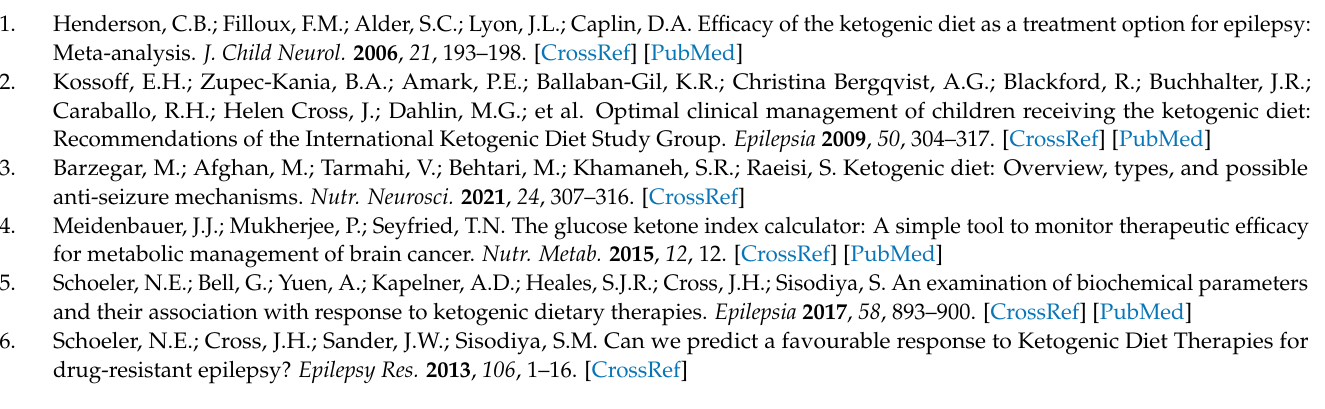
study; Figure S2: Parameters related to graph theory-based electroencephalographic connectivity in patients presenting FOS with left or bilateral EEG lateralization and age-matched controls. Figure S3: Parameters related tograph theory-based electroencephalographic connectivity inpatients presenting FOS with left or bilateral EEG lateralization after 12 months of KDT and age-matched controls. Figure S4: Parameters related to graph theory-based electroencephalographic connectivity in patients presenting FOS with left or bilateral EEG lateralization at KD initiation and after 12 months of